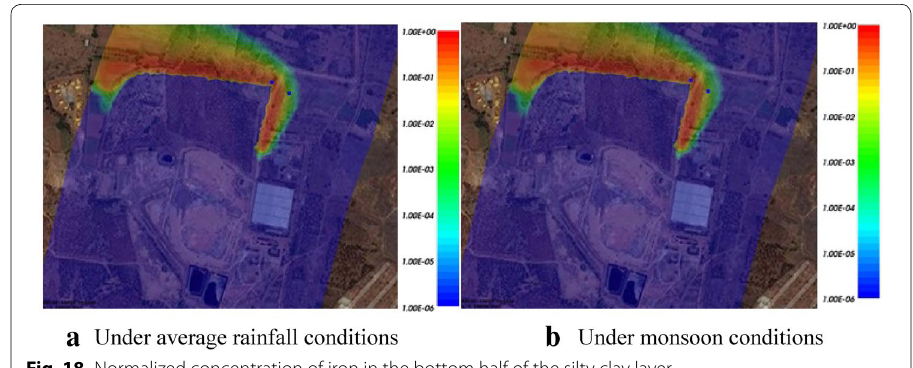
Fig. 18 Normalized concentration of iron in the bottom half of the silty clay layer